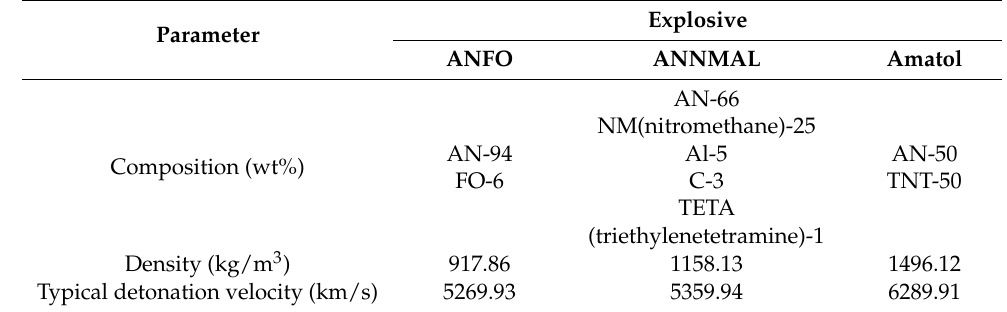
Table 1. Comparison of detonation composition and detonation velocity in commonly used, industri-